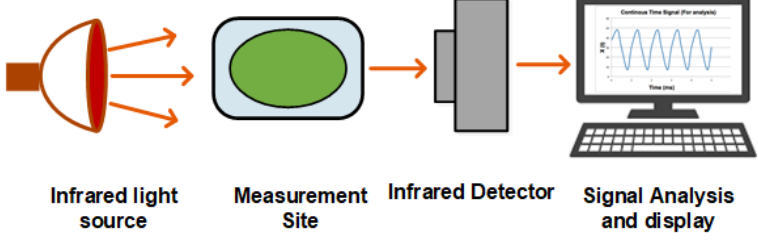
Figure 2. Infrared spectroscopy. Figure 2. Infrared